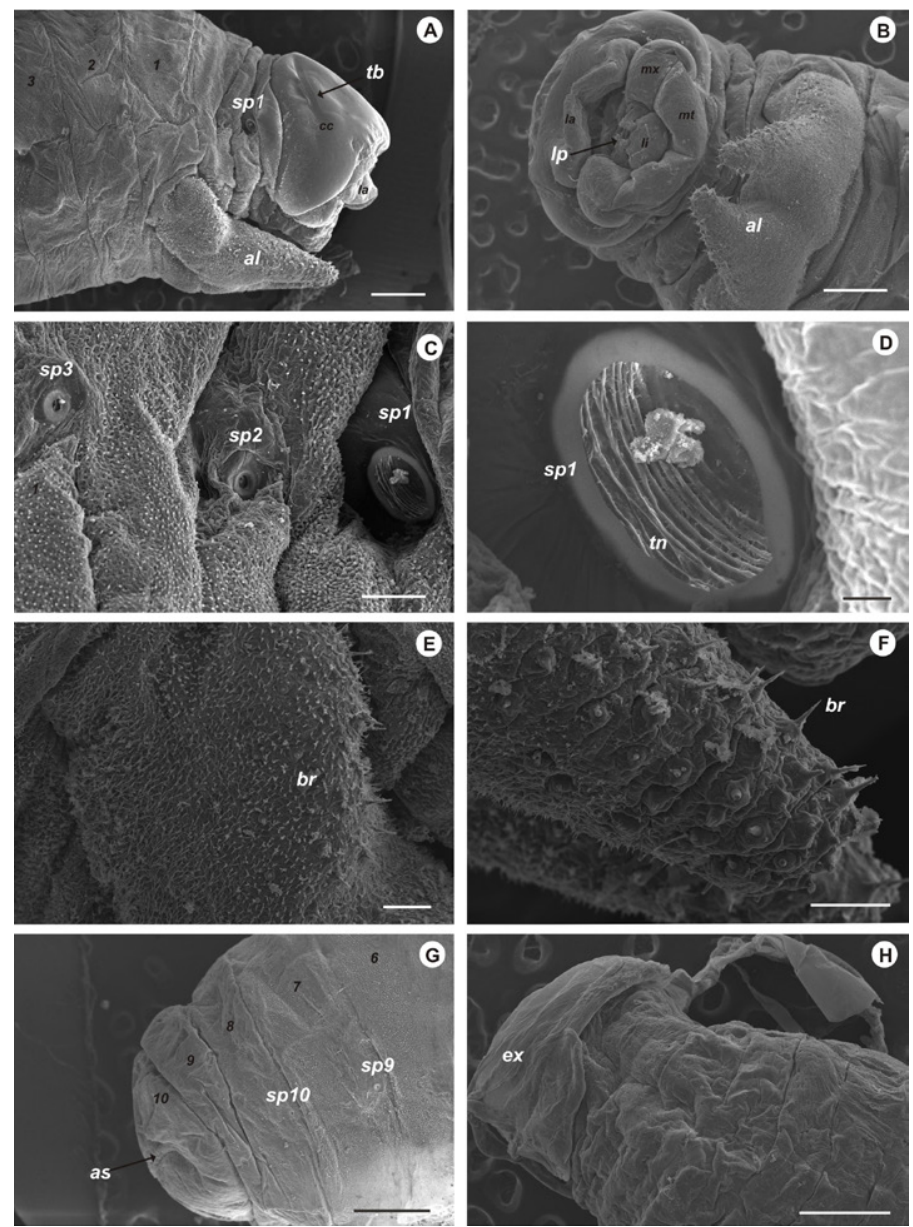
Fig 3. Larva 5 (A to G) and Larva 4 (H) of Mischocyttarus nomurae (Hymenoptera, Vespidae): A – side view of the frontal region; B – ventral view of the frontal region; C – detail of the spiracles; D – detail of the 1 st spiracle; E – basal portion of the right side abdominal lobe; F – apical portion of the right side abdominal lobe; G – detail of posterior region; H – detail of posterior region. al - abdominal lobe, as – anal slot, br – bristles of lobes, cc – cephalic capsule, ex – exuviae; la – labrum, li – labium, lp – labial papilla, mt – mentum, mx – maxilla, sp1 – spiracle between the prothorax and the mesothorax, sp2 – spiracle between the mesothorax and the metathorax, sp3 – spiracle of the 1 st abdominal segment, sp9 – 9 th spiracle, sp10 – 10 th spiracle, tb – temporal band , tn – taenidia. Numbers in black indicate the abdominal segments. Scale bar: A, B, G, H = 500µm; C, E, F = 100 µm; D = 20